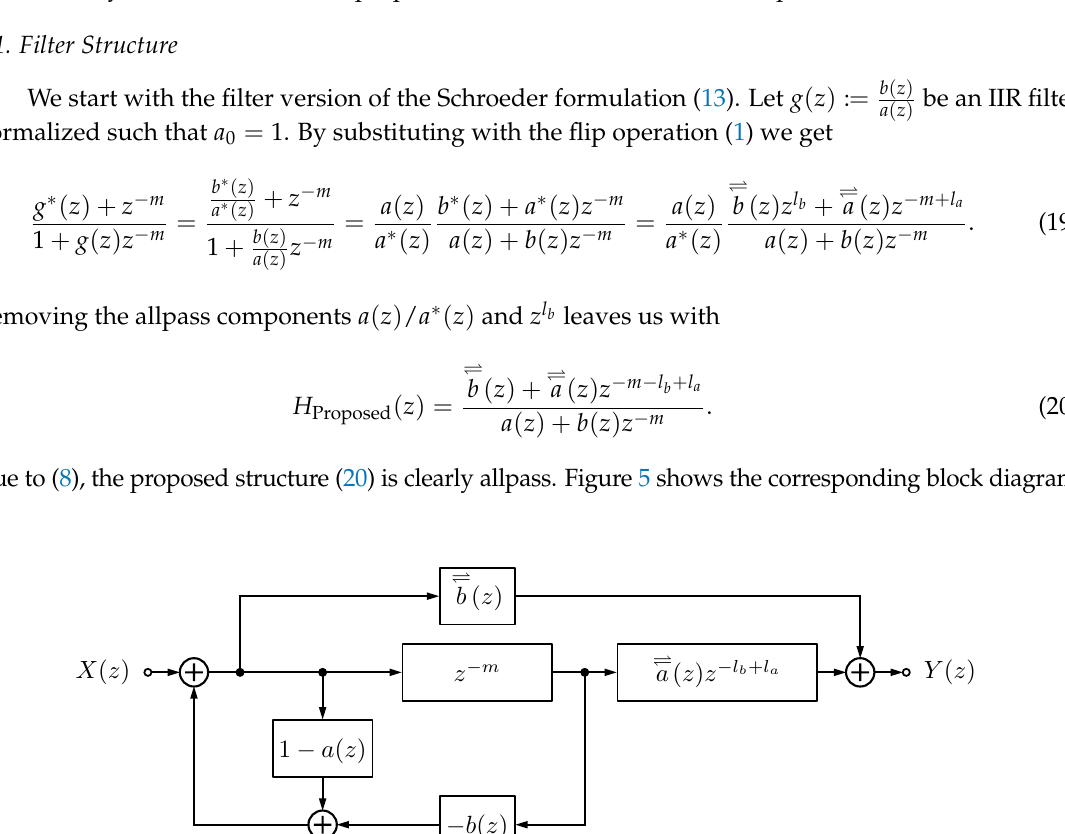
Figure 4. Numerical example of a Dahl absorbent allpass filter. ( a ) Poles and zeros of the gain H Dahl ( z ) ( / ) and proportional magnitude response × ◦ H Dahl ( z ) of . | |